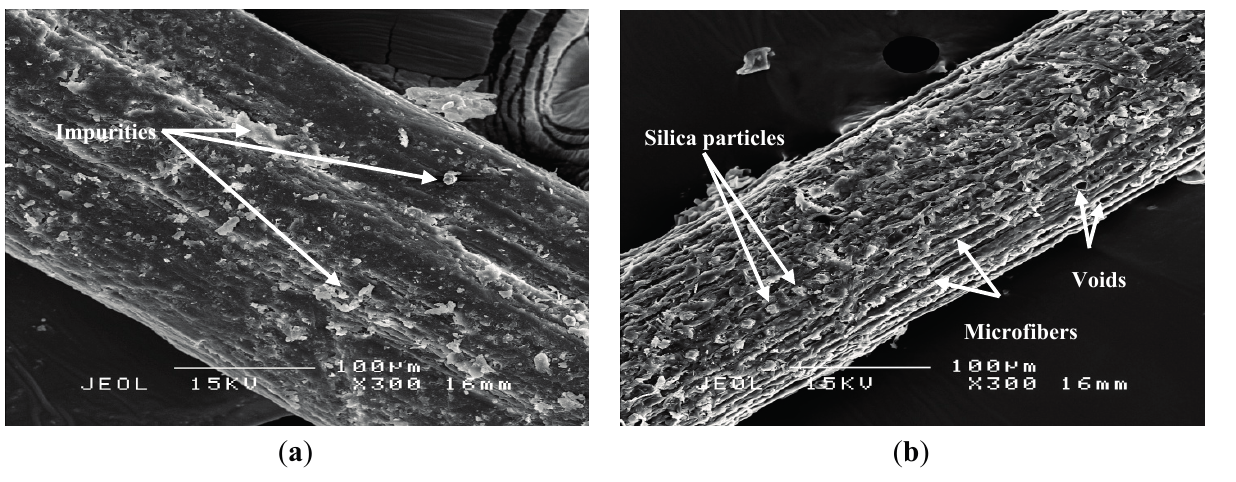
Figure 2. SEM micrographs of ( a ) OPMF and ( b )